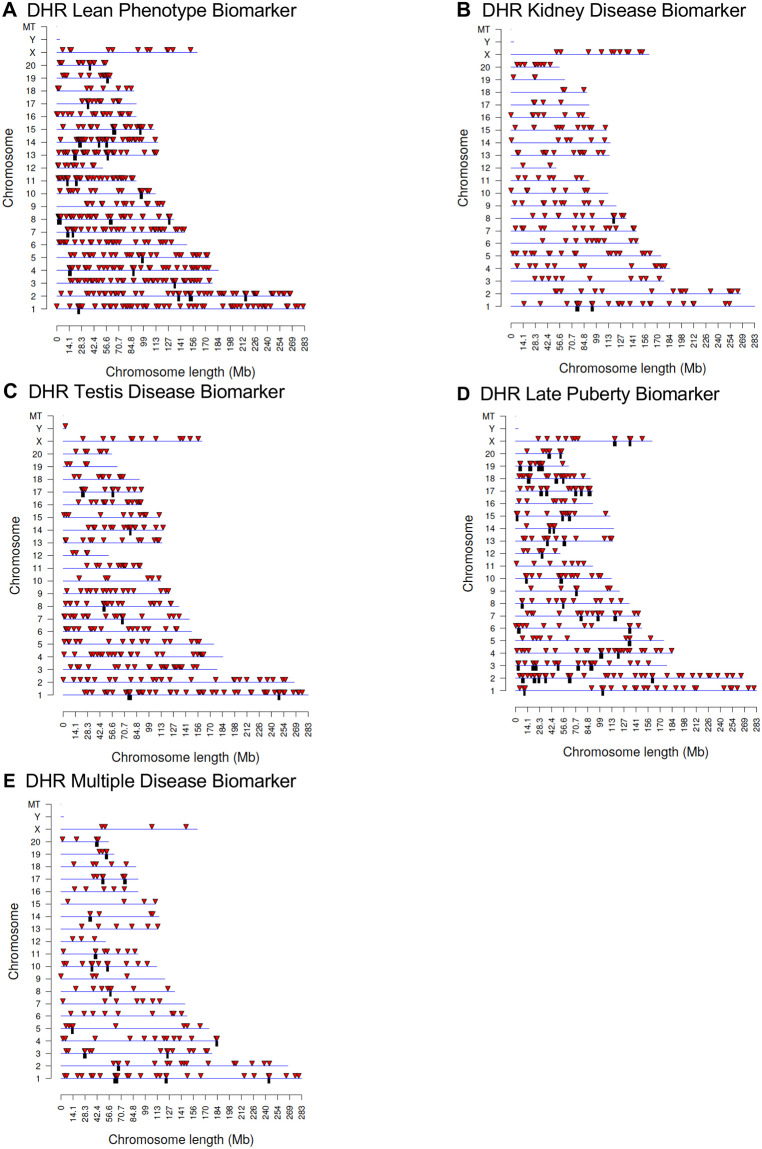
DHR chromosomal locations.The DHR locations on the individual chromosomes is represented with an arrowhead and a cluster of DHRs with a black box. All DHRs containing at least one significant window at a p-value threshold of 1e-04 for DHR are shown. (A) Lean phenotype DHRs (p<1e-5); (B) Kidney disease DHRs; (C) Testis disease DHRs; (D) Late puberty DHRs; and (E) Multiple disease DHRs.